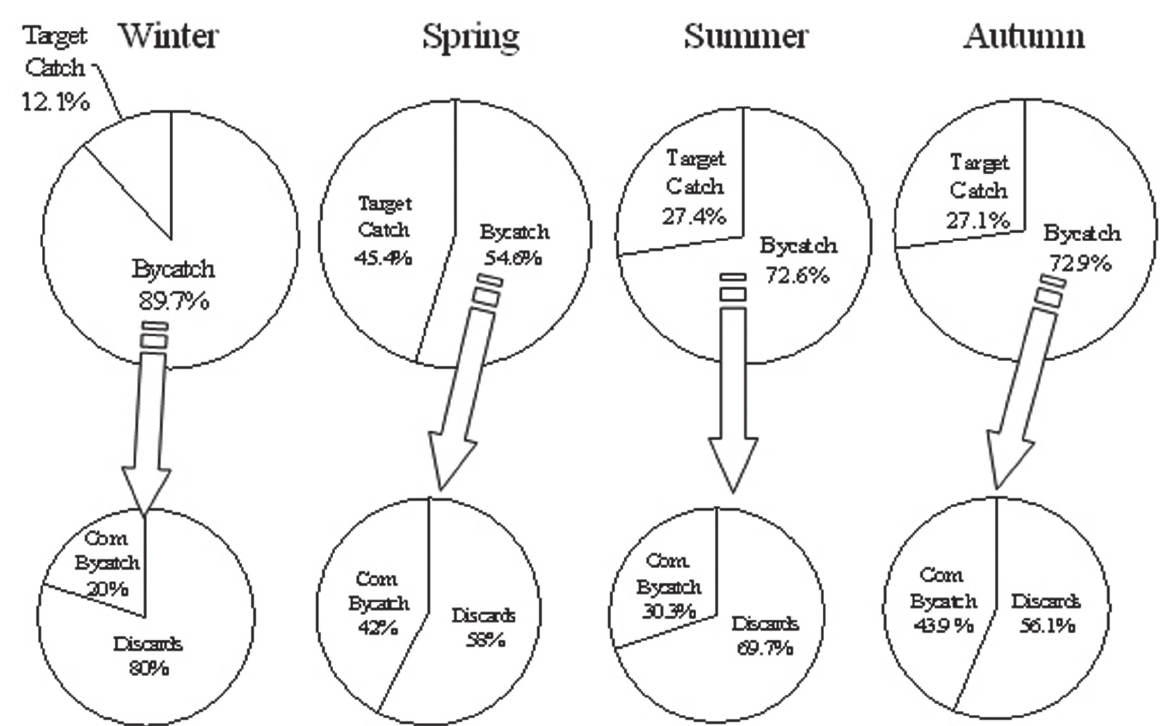
Fig . 4. – overall catch composition of the fish trawl according to